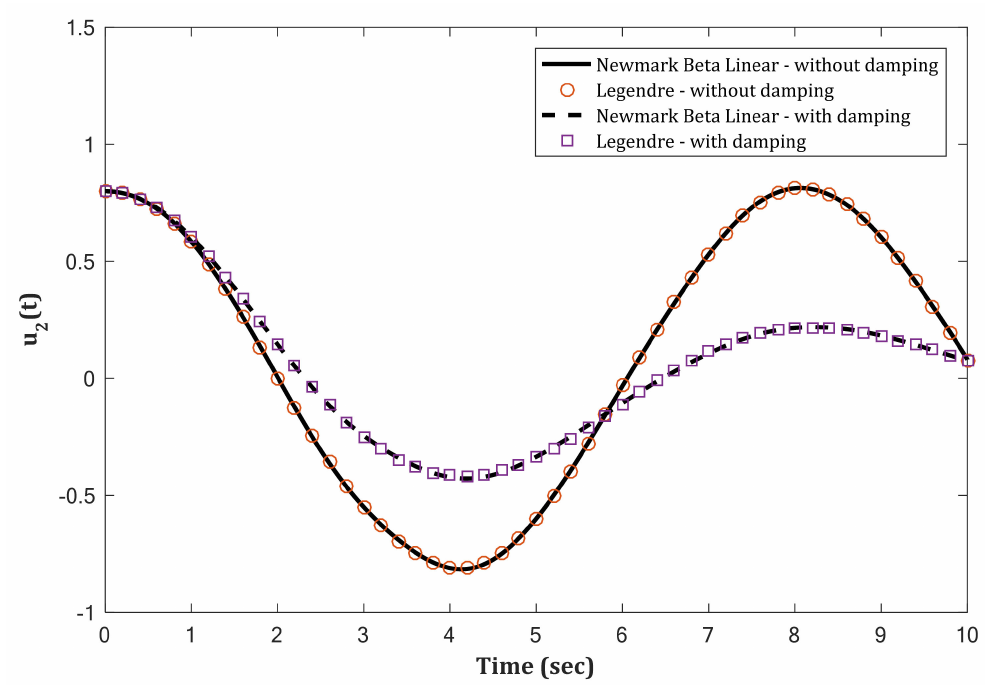
Figure 14. Free vibration analysis of a 5DOF system. Comparison of u 2 ( t ) as a function of time, as obtained using the LGM method or the linear Newmark- β